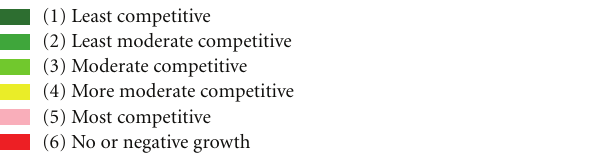
Figure 5: Competition index on resource utilization within a 128.8 km one way travel